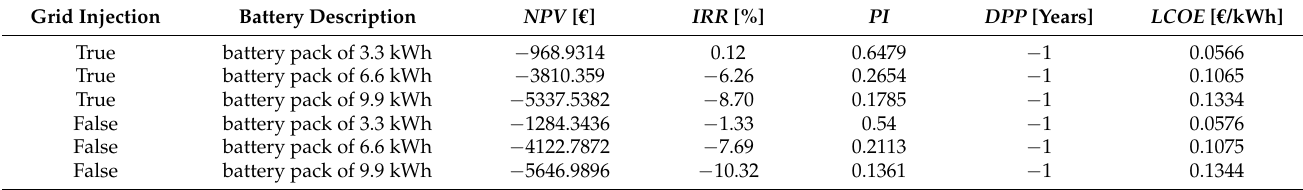
Table 12. Economical results for 1.5 kWp PV setup (individual battery packs).